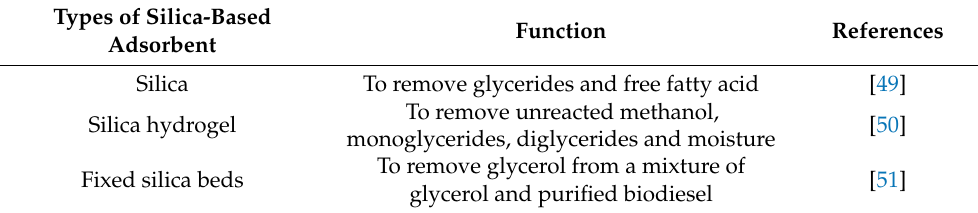
Table 3. Comparison of different silica-based adsorbents and their functions. Types of